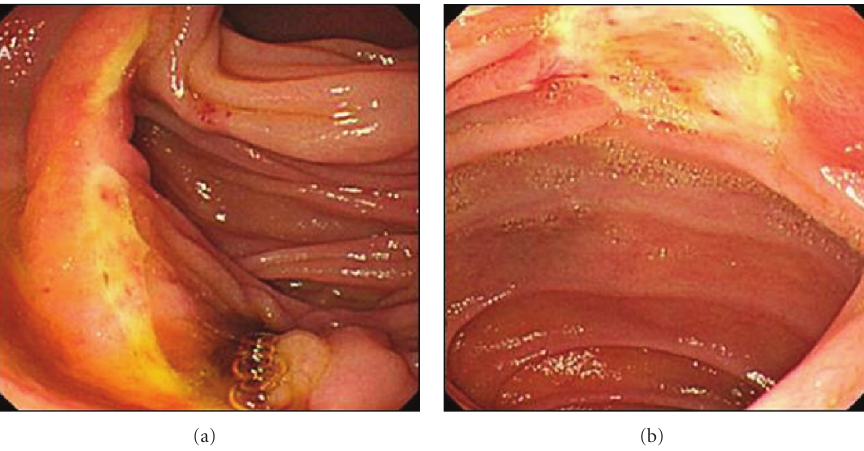
Figure 3: Representative images of the marginal ulcer bleeding in a patient with subtotal gastrectomy. (a) A linear ulceration was observed at anastomosis site. (b) A round ulcer was found on e ff erent side of Billroth-II anastomosis. And there were red spots on the base of